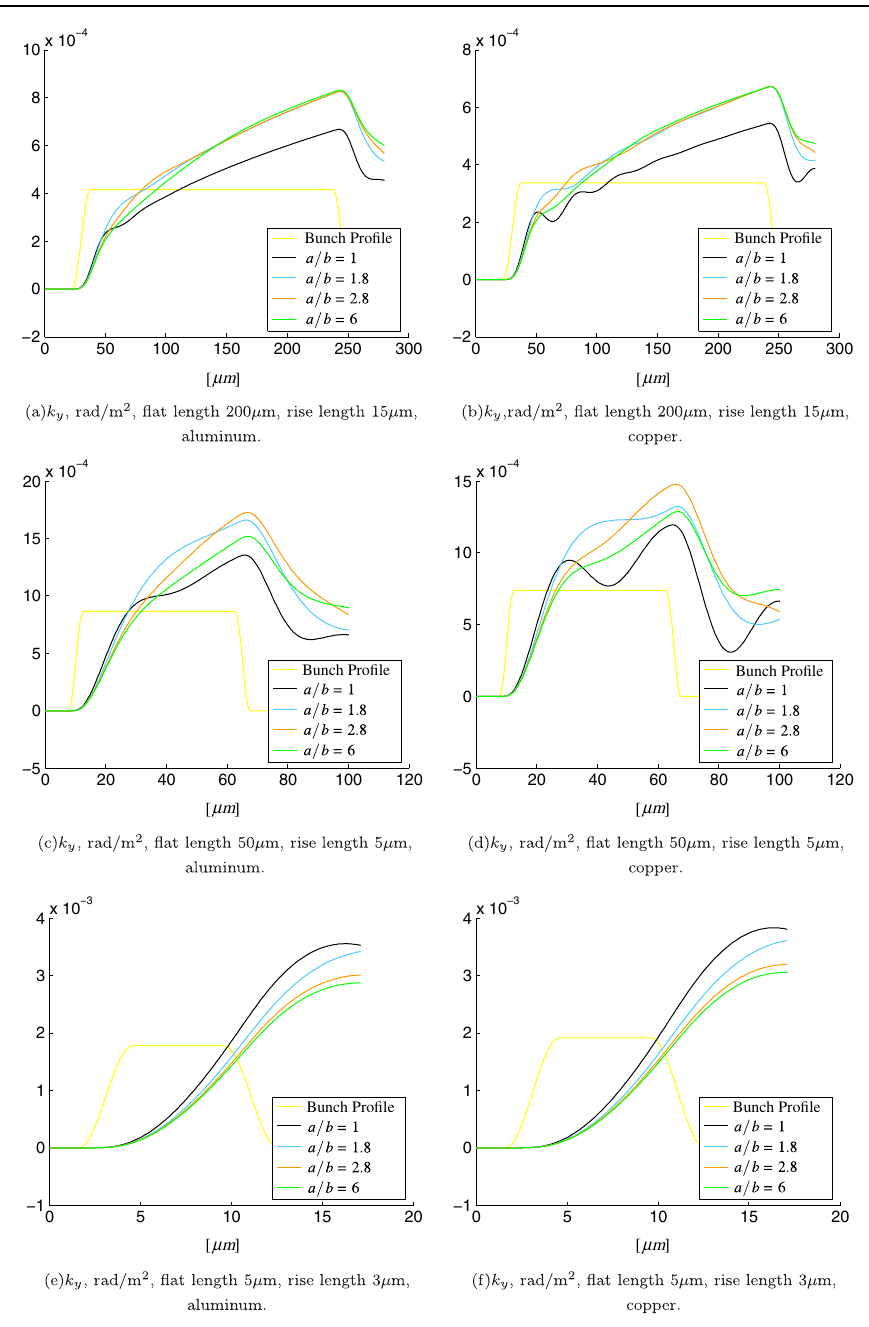
FIG. 9. (Color) Transversal kick per unit length and off-axis displacement, along the short axis direction, induced within flattop bunches with different lengths and charge 1 nC at 1.2 GeV. Semiminor axis b (cid:4) 3 mm , AC conductivity model, and several aspect ratio values a=b are